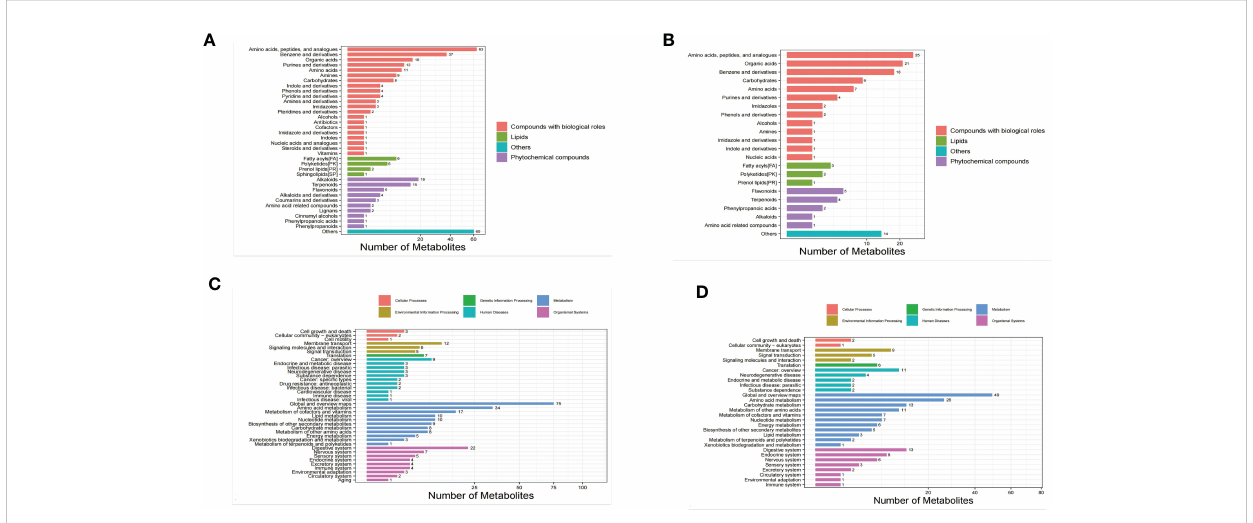
FIGURE 2 Bar chart of metabolite classi fi cation in the positive ion mode ( A ) and negative ion mode ( B ). X-axis represents the number of metabolites in each class, Y-axis represents the metabolite classi fi cation entries. Bar chart of KEGG functional annotation of metabolites in the positive ion mode ( C ) and negative ion mode ( D ).